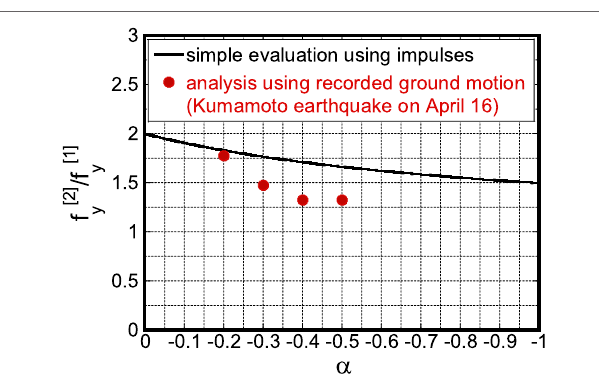
FIGURE 8 | f [2] y = f [1] y for ααα (including analysis for recorded ground motion)